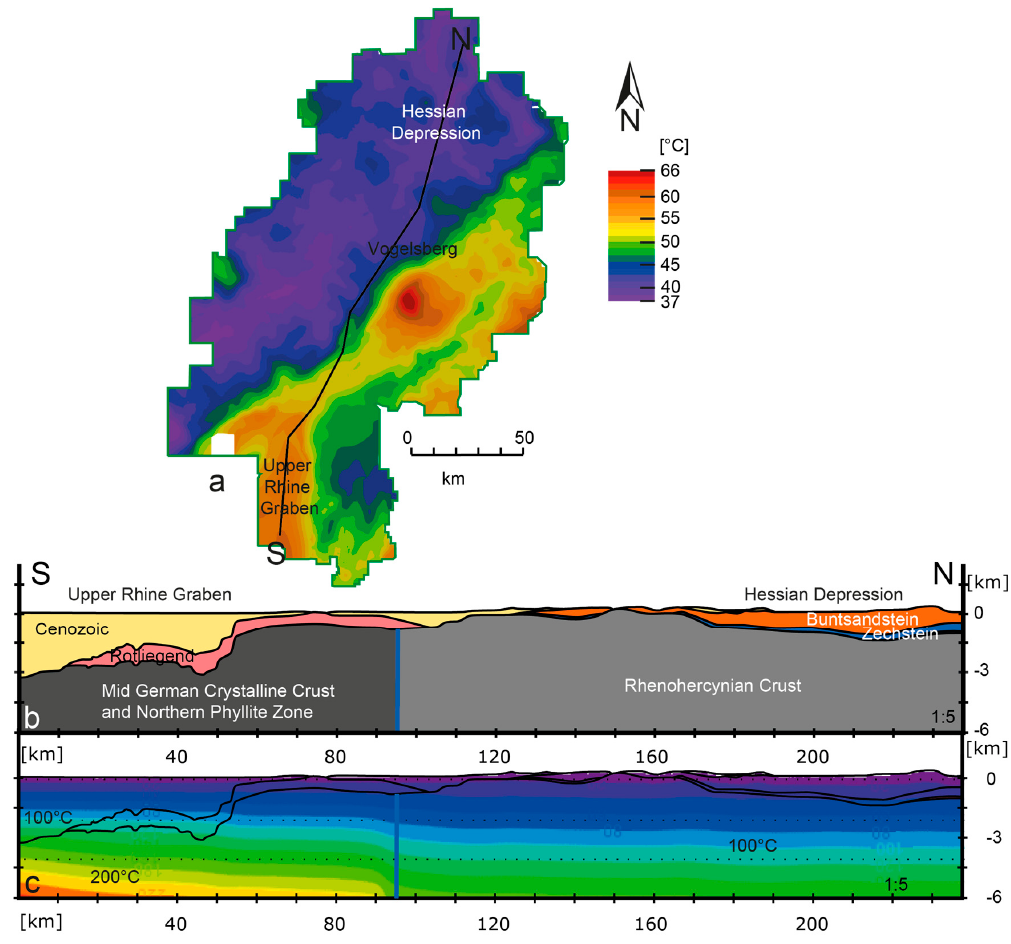
Figure 6. Conductive thermal configuration. ( a ) temperature map at a 1 km depth and ( b ) a geological profile from south to north. The blue line in the profile depicts the border of the crustal Variscan domains, ( c ) simulated temperatures along this profile.